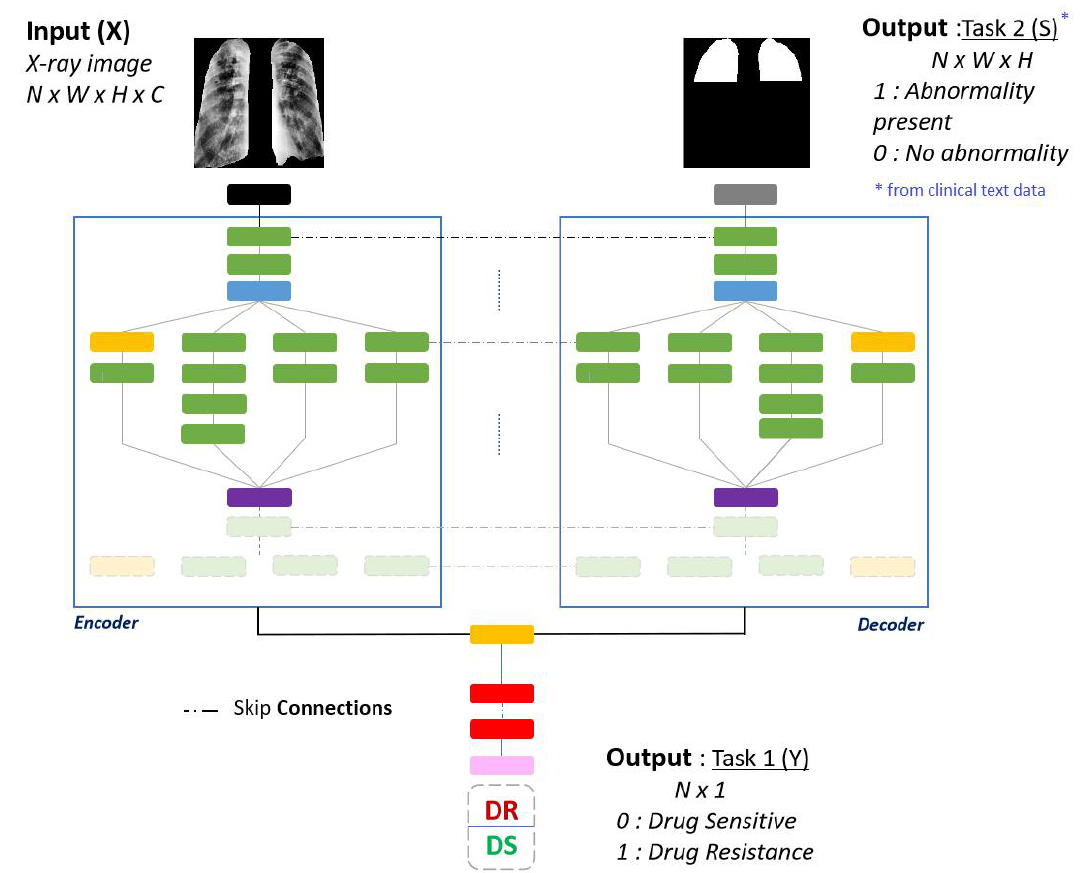
Figure 7. Multi-output network for the additional task of abnormality segmentation. The pretrained backbone (ResNet18) is modified to be a U-Net with encoder and decoder. The inputs for this network are chest X-ray images whereas the segmentation output masks are derived from the clinical text